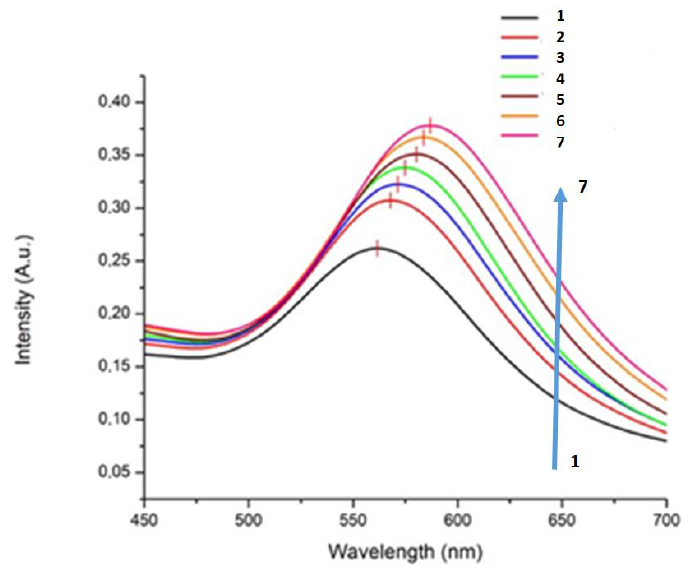
Figure 5. LSPR spectra in the presence of five gliadin concentrations and anti-IgG antibody in aqueous solution for biofunctionalization of metallic nanostructures: (1) annealed 4 nm AuNPs; (2) anti-gliadin/MUA/AuNPs; (3) 0.1 ppm gliadin; (4) 1 ppm gliadin; (5) 10 ppm gliadin; (6) 100 ppm gliadin; (7) 1000 ppm gliadin. (A.u.—absorbance units).